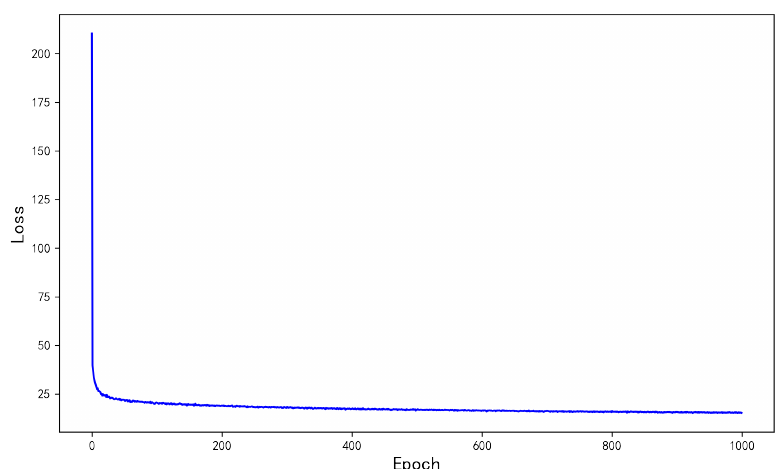
Figure 4. Training process for Concrete dataset when learning the rate is 0.005.